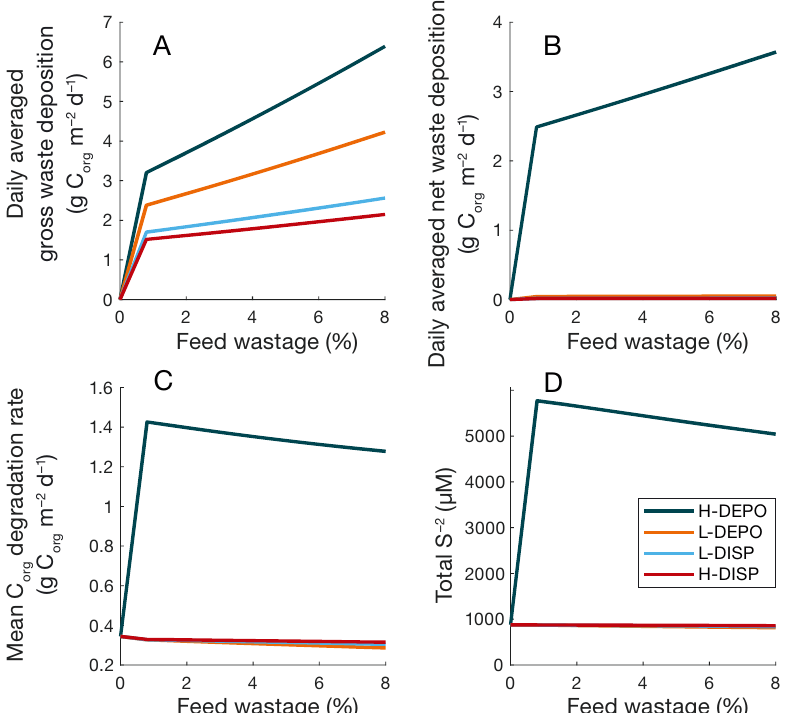
Fig. 6. Prediction of benthic processes in fish farm sediments exposed for the first time to fish farm organic wastes according to parameters given in Table 1, and assuming a feed wastage between 0 and 8% (in increments of 0.8%). Sim- ulations assume twice-per-day feeding and a percent feed wastage between zero (ambient deposition) and 8%. The coloured lines represents different hydrodynamic scenarios: high and low deposition (H- and L-DEPO) and low and high dispersion (L- and H-DISP). (A) Daily averaged gross waste deposi- tion. (B) Daily averaged net waste deposition. (C) Mean total C org degradation of ambient particulate organic carbon and fish farm wastes. (D) Maximum total S 2− concentration predicted throughout the fish farm cycle. The break observed between 0% feed wastage and increasing values is caused by the transition from ambient deposition to farm